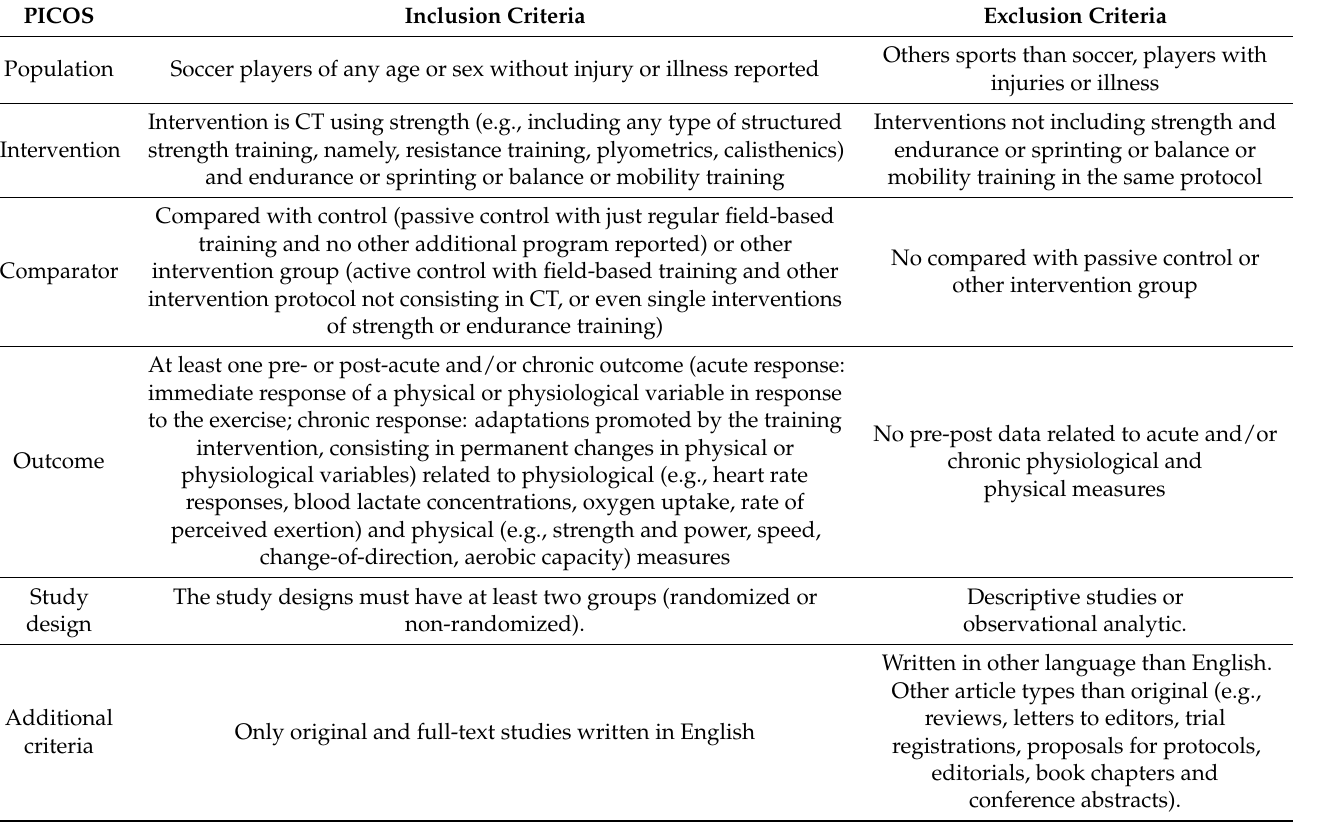
Table 1. Inclusion and exclusion